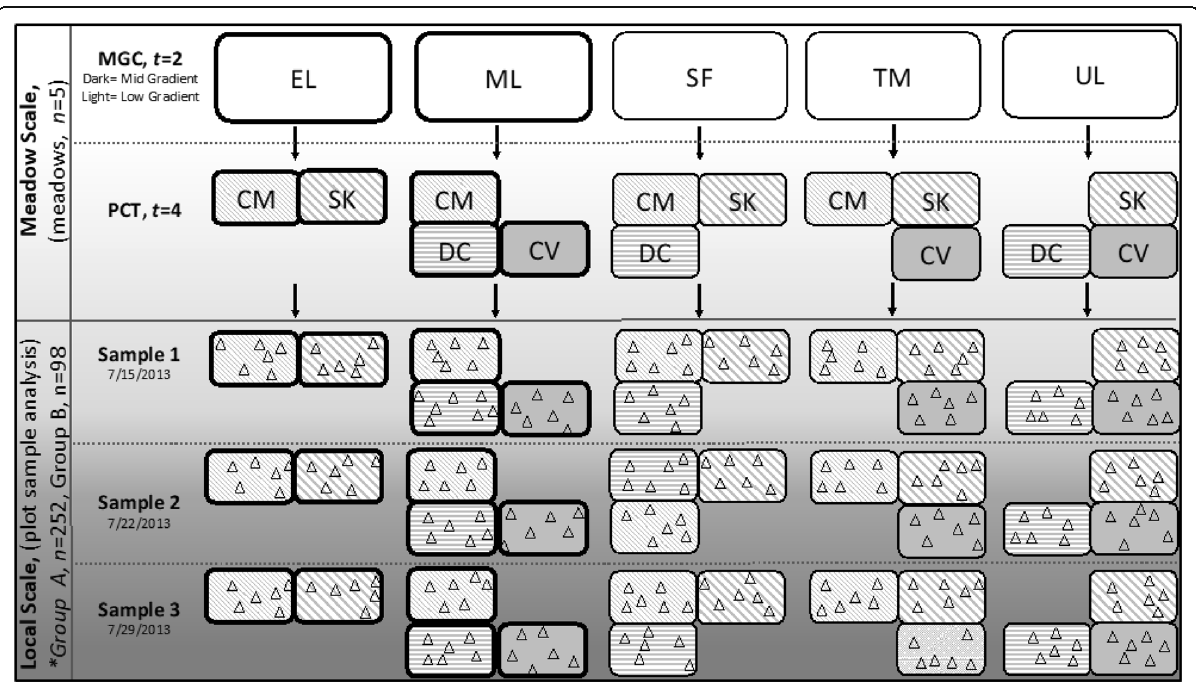
Fig. 2 Schematic of stratified random sampling design. Five subalpine meadows were studied within Yosemite National Park, USA, comprised of two different meadow gradient classes. Middle (Mid) gradient (shown by thick outline boxes) included Emeric Lake (EL) and Middle Lyell (ML). Low gradient (shown by thin outline boxes) included Snow Flat (SF), Tuolumne Meadows (TM), and Upper Lyell (UL). Plant community types (PCTs, two to three sampled per meadow, shown by differently patterned boxes) included Calamagrostis muiriana (CM), Carex vesicaria (CV), Deschampsia cespitosa (DC), and Stipa kingii (SK). Soil and vegetative cover sampling occurred over three study weeks in July of 2013: July 15th (sample 1), July 22nd (sample 2), and July 29th (sample 3). Weekly sampling occurred within randomized plots within PCTs. * Plot sample analysis was done for the soil resistance response variable and 14 explanatory variables: group A ( n = 252, derived from sampling six plots with two combined replicates per plot, per PCT) — soil resistance, soil bulk density, soil gravimetric water content, soil volumetric water content, soil coarse fragments 2 – 4 mm in diameter, soil coarse fragments > 4 mm in diameter, total vegetation cover (at 1 m 2 and 700 cm 2 scales), root mass areal density, and root content; group B ( n = 98) — soil water holding capacity, soil organic matter content, sand content, silt content, and clay